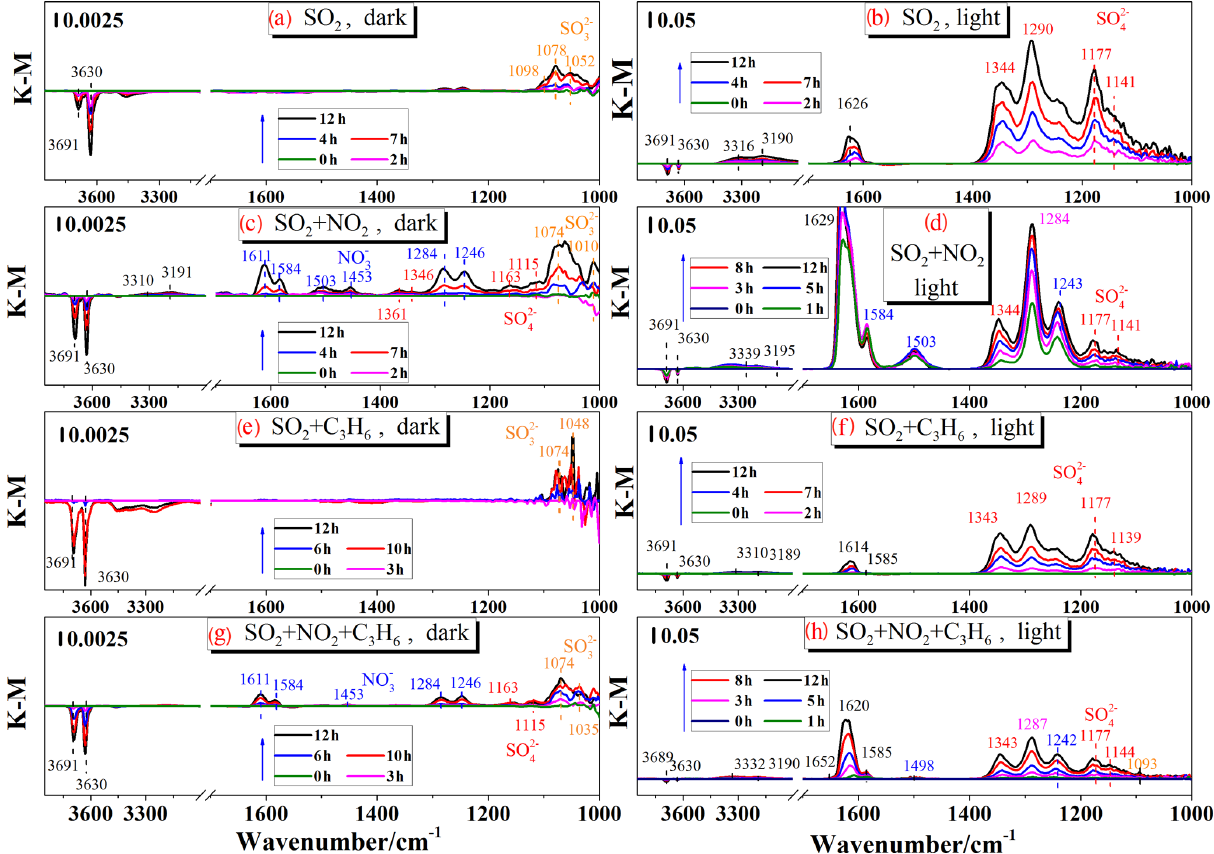
Figure 1. Dynamic changes in the in situ DRIFTS spectra of the TiO 2 sample as a function of time at 303K in a flow of 20% O 2 + 80% N 2 with 200ppb SO 2 under dark conditions (a) and with UV–Vis light (b) ; with 200ppbSO 2 + 200ppbNO 2 under dark conditions (c) or with UV–Vis light (d) ; with 200ppbSO 2 + 200ppbC 3 H 6 under dark conditions (e) or with UV–Vis light (f) ; with 200ppbSO 2 + 200ppbNO 2 + 200ppbC 3 H 6 + under dark conditions (g) or with UV–Vis light (h) . obtained for the SO 2 + C 3 H 6 reaction but the intensities were